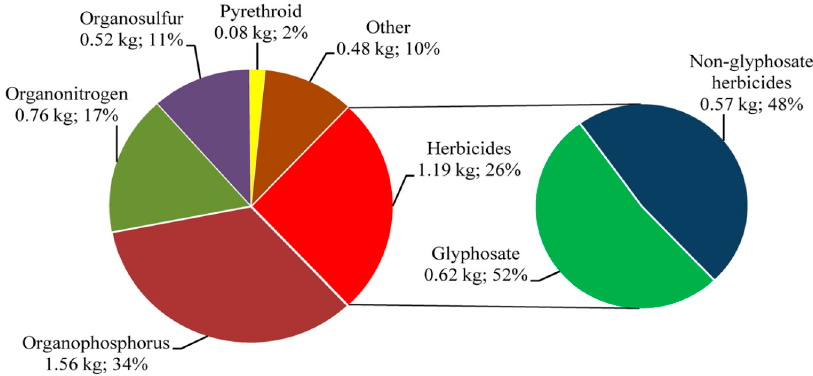
Figure 1. Summary of agricultural use of each class of pesticide in China [24].